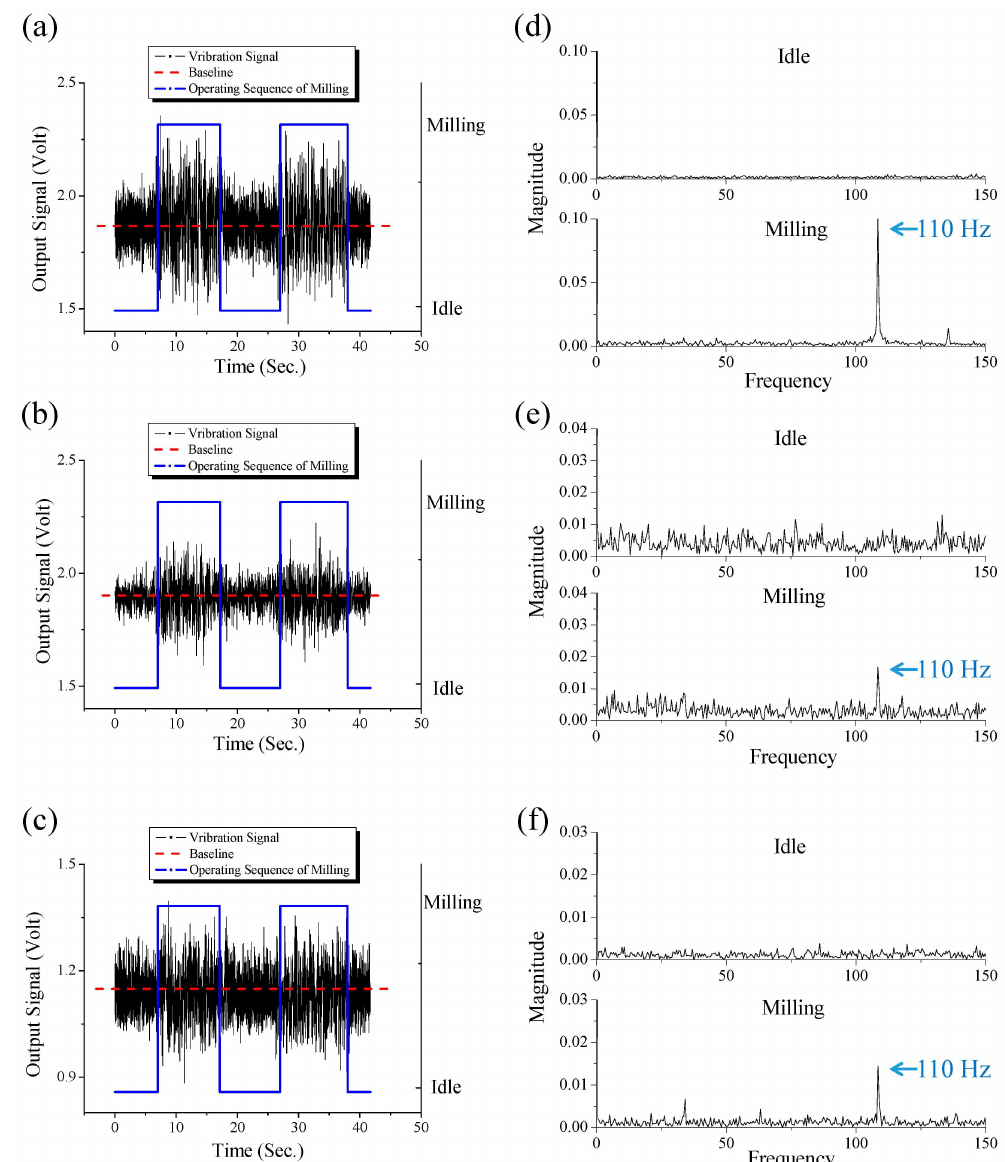
Figure 6. The ( a ) x-axial; ( b ) y-axial; ( c ) z-axial time-domain-based vibration signals received by using the system in milling processes. The corresponding ( d ) x-axial ( e ) y-axial ( f ) z-axial frequency-domain-based vibration signals for “idle” and “milling” statuses in milling processes. These frequency-domain results are obtained by applying Fast-Fourier Transform to ( a ), ( b ), and ( c ), respectively.